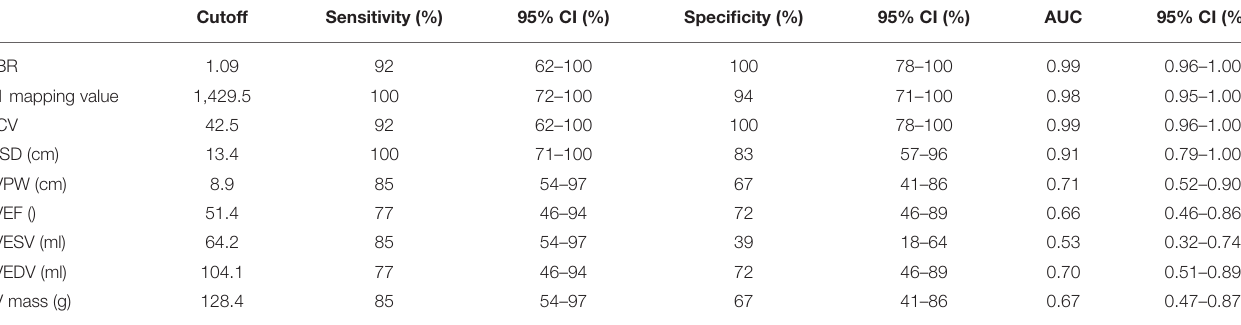
TABLE 5 | Differential diagnostic efficiency of TBR and CMR parameters between cardiac amyloidosis (CA) patients and control subjects (non-CA patients‘ and healthy subjects).